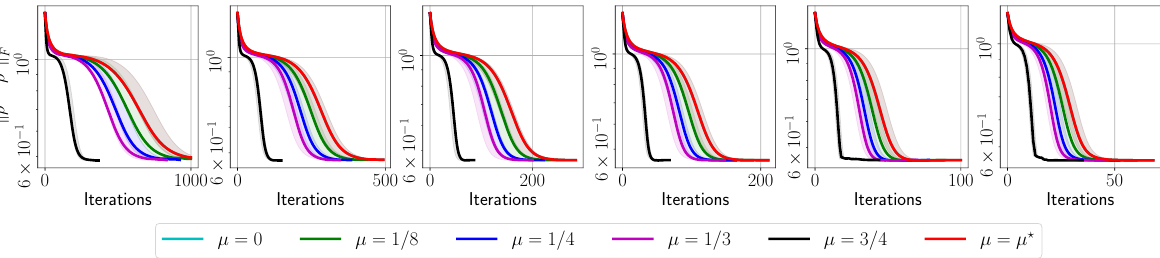
Figure A8. Fidelity list plots for reconstructing GHZ IBM Quantum system experiments and synthetic measurements from Qiskit simulation experiments.